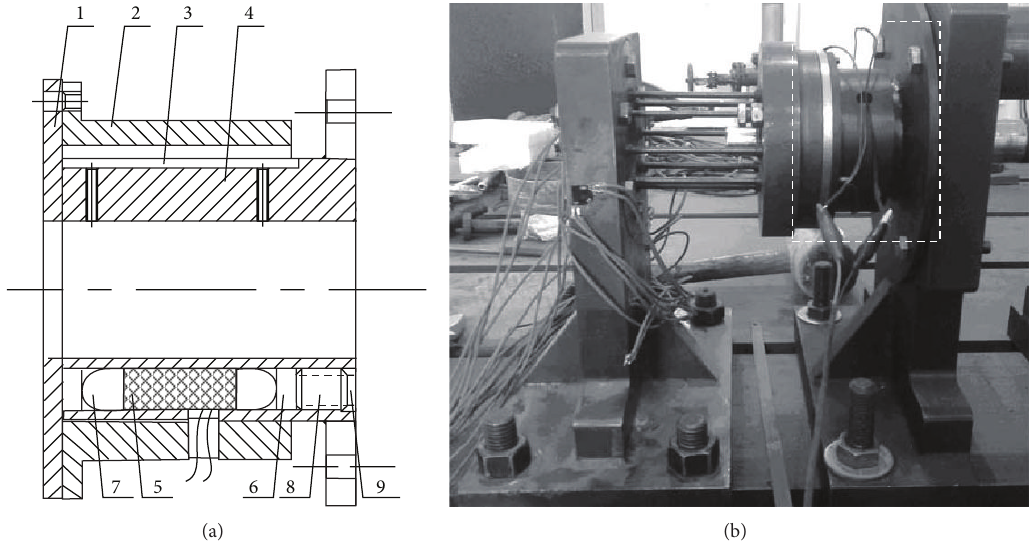
Figure 11: The elastic support/dry friction damper with piezoelectric ceramic actuator (1: stationary disk, 2: sleeve, 3: diving key, 4: support cylinder, 5: piezoelectric ceramic, 6: small disc, 7: hemisphere, 8: preload bolt, and 9: preload bolt